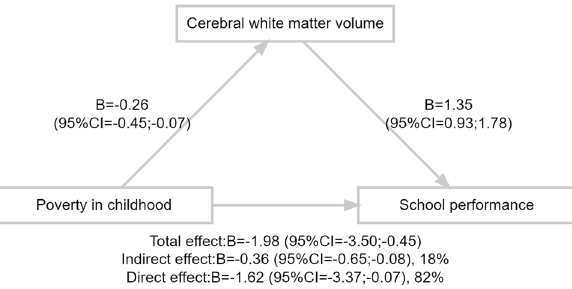
Figure 4. Mediating role of cerebral white matter volumes on the association between exposure to childhood poverty and school performance in children from Dutch majority group. Total sample: n = 1365. Model adjusted for: poverty → cerebral white matter volume: child age at brain measurement, child sex, maternal education at pregnancy, maternal IQ, maternal and paternal psychiatric symptoms at pregnancy; cerebral white matter volume → school performance: child age at CITO assessment, child age at brain measurement, child sex, maternal education at pregnancy, maternal IQ, maternal and paternal psychiatric symptoms at pregnancy; poverty → school performance: child age at CITO assessment, child sex, maternal education at pregnancy, maternal IQ, maternal and paternal psychiatric symptoms at pregnancy. CITO score was derived from a mandatory academic test conducted in the final grade of primary school and a proxy of school performance. Higher score indicates higher levels of school